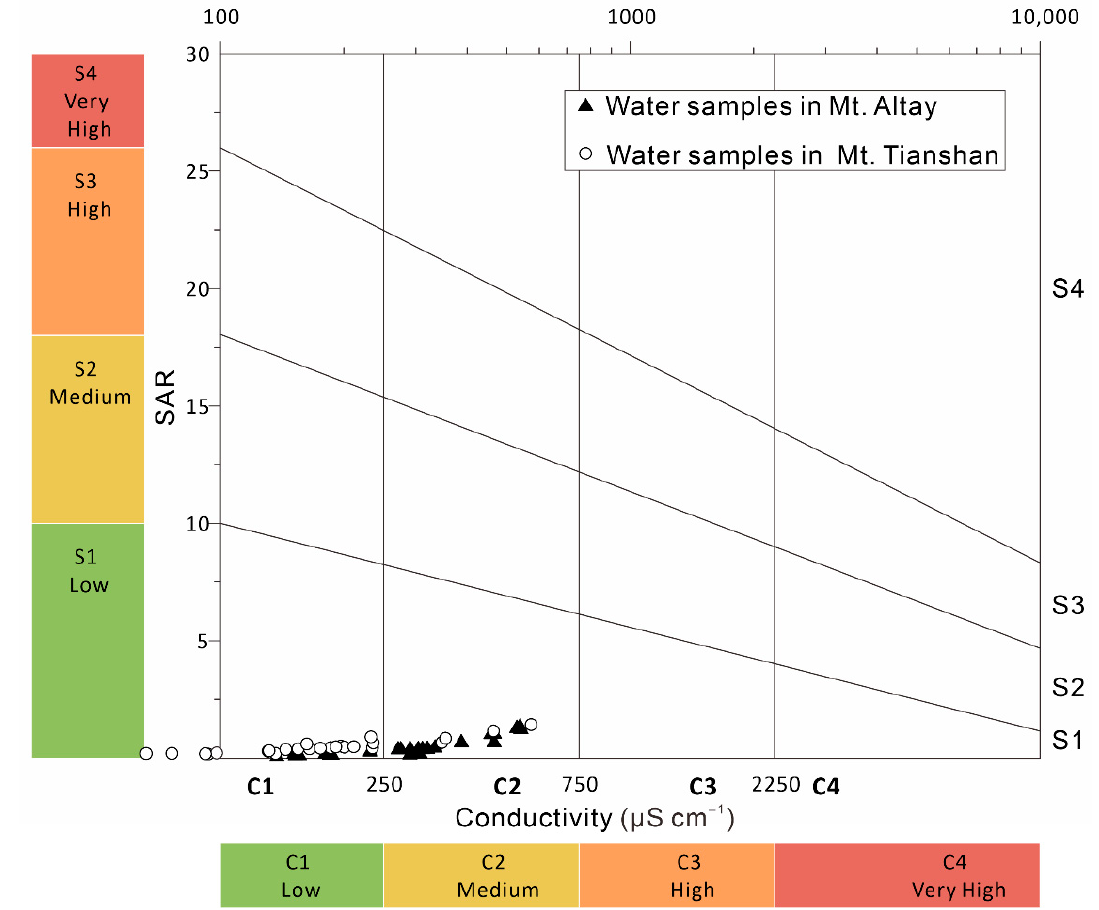
Figure 5. The irrigation assessment for the water samples from the regions of the Tianshan and Altay Mts. using a United States salinity diagram (USSL).